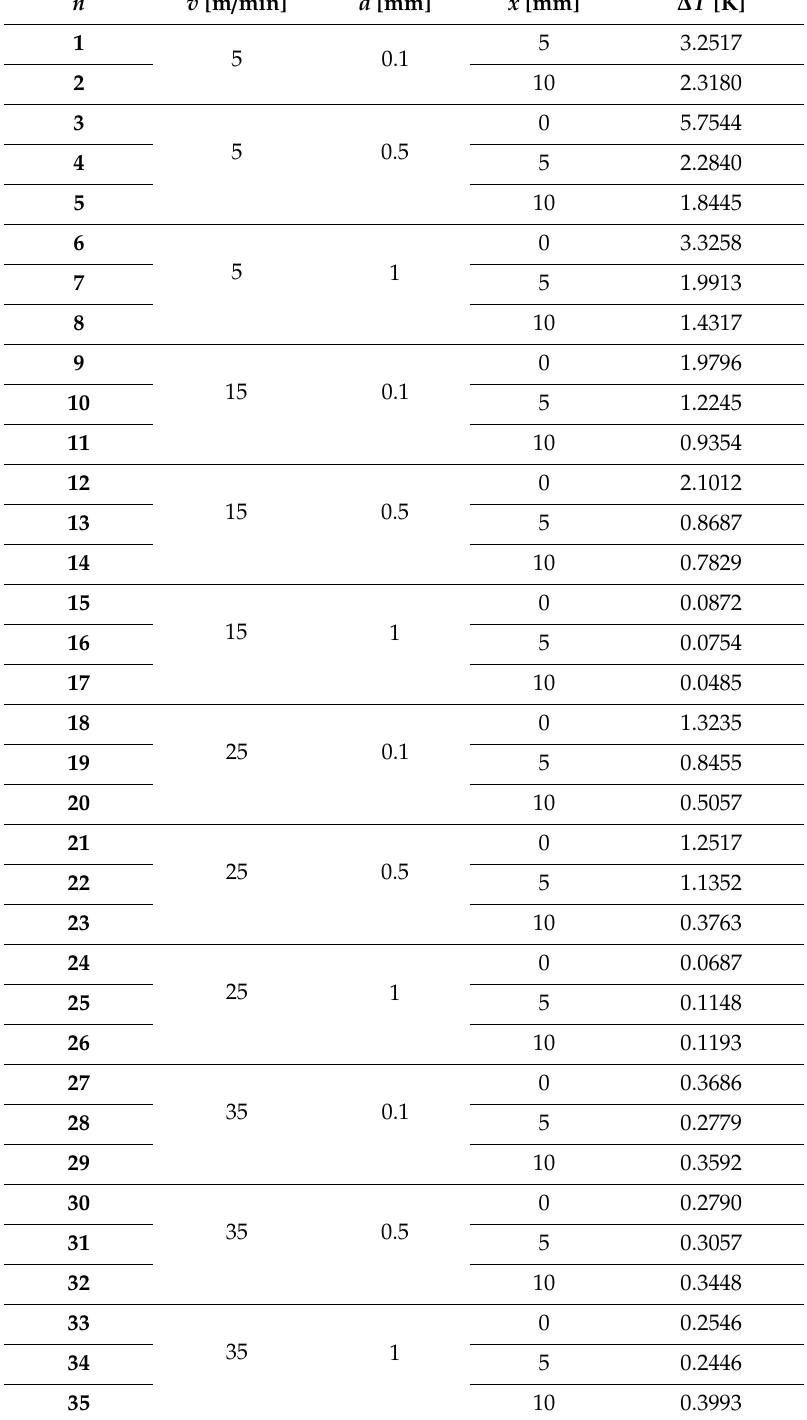
Table 1. The temperature di ff erences or temperature drops in Inconel 718 for respective input parameters